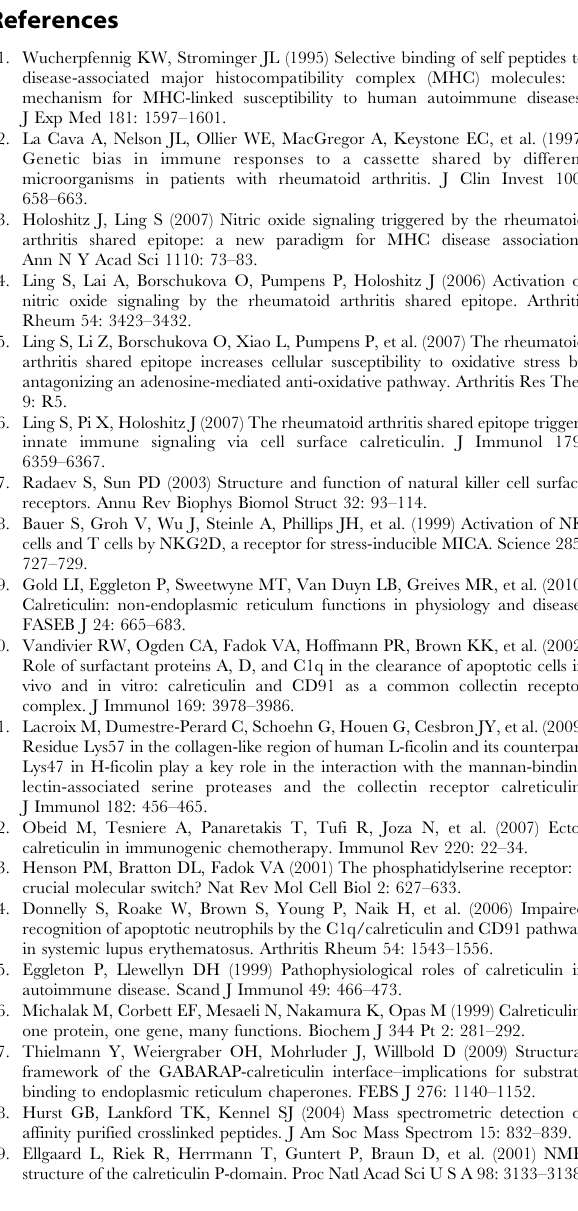
Figure S1 CD spectra of WT CRT and its mutants. Proteins, in a 5 mM HEPES (pH 7.4), 100 mM KF, 2 mM CaCl2 buffer were